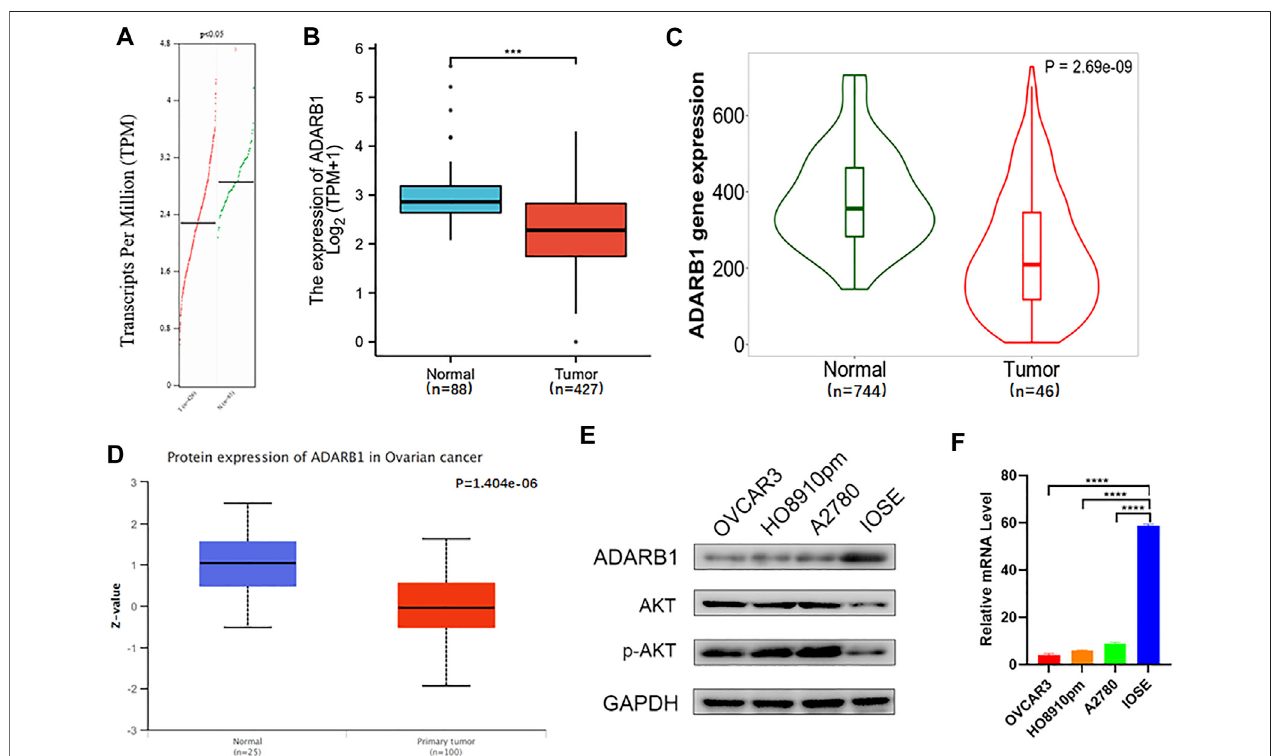
FIGURE1| DownregulationofADARB1inOCtissuesandcelllines. (A – D) TheexpressionofADARB1wasanalyzedbythe (A) GEPIA, (B) TCGA, (C) TNMplot (D) UALCAN databases, respectively. (E,F) Expression of ADARB1 was analyzed by RT-PCR and western blot.